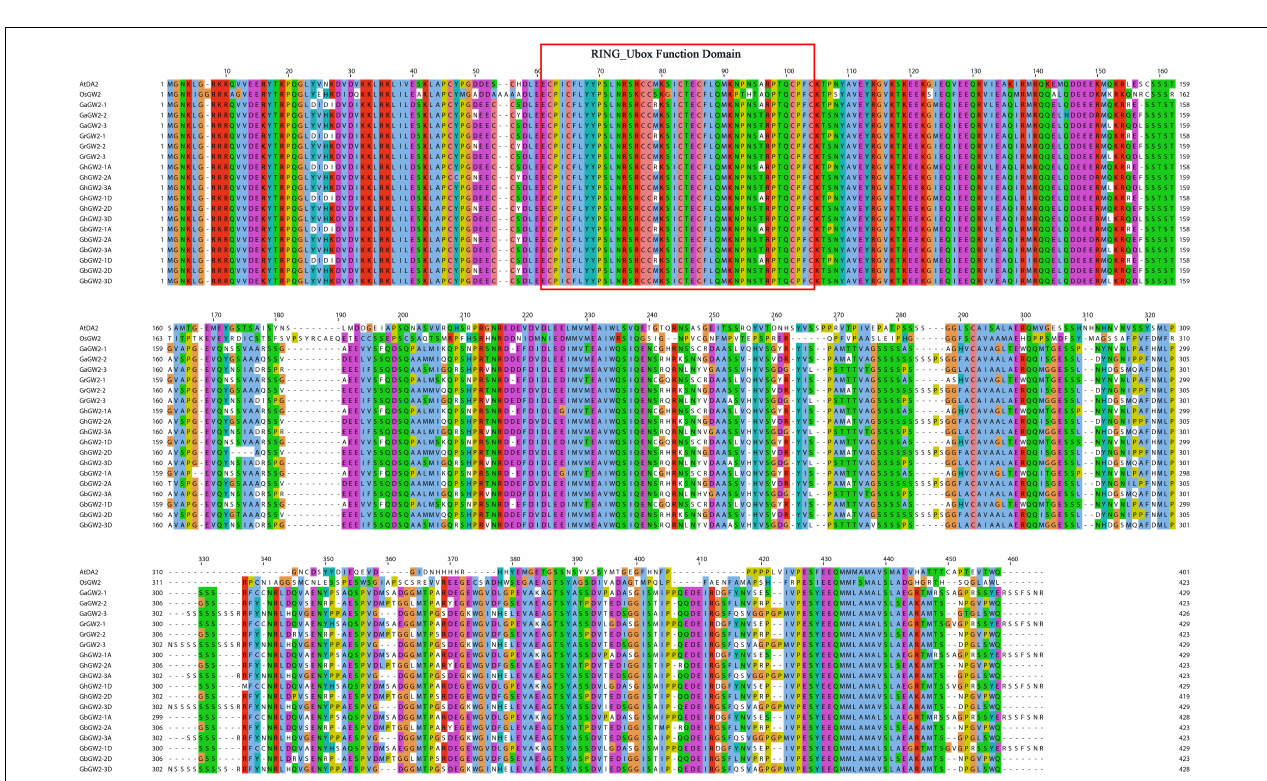
FIGURE 3 | qRT-PCR of Gh GW2 s in ovules. Relative expression level of GhGW2-1A (A) , GhGW2-1D (B) , GhGW2-2A (C) , GhGW2-2D (D) , GhGW2-3A (E) , GhGW2-3D (F) . GhActin3 was selected as internal and the 1 Ct value of 0-DPA-ovules was set as the control. The data presented are the means ± SD of three replicates.